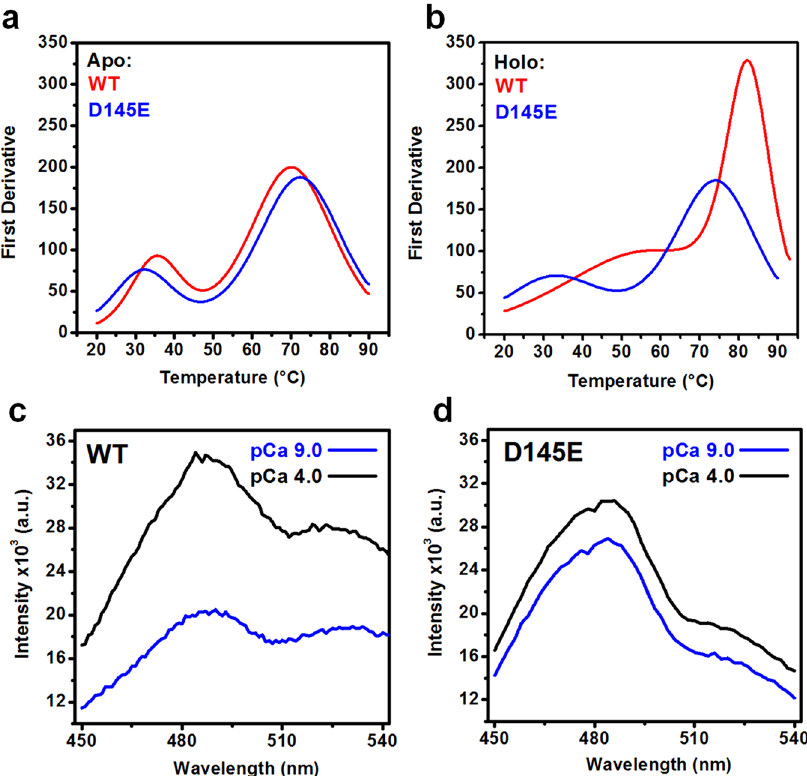
Figure 2. Thermostability and hydrophobic exposure of WT and D145E. Mean residue ellipticity at 222 nm was measured for HcTnC WT and D145E. Data shown are sample derivatives from 3 experiments with 2 different protein batches in apo (a ) and Mg 2 + /Ca 2 + -bound ( b ) states. All melting curves were run in reverse after reaching 90 °C, and the structural changes promoted by temperature were reversible. For average values, see text. In ( c ), 5 μ M bis-ANS was excited at 360 nm in the presence of 1 μ M WT or D145E to compare fluorescence intensity at low (pCa 9.0) and high (pCa 4.0) Ca 2 + concentrations as a measure of binding to hydrophobic surface areas. Average ratios (holo/apo ± s.e.m.) were 1.68 ± 0.11 for WT and 1.13 ± 0.02 for D145E (p =